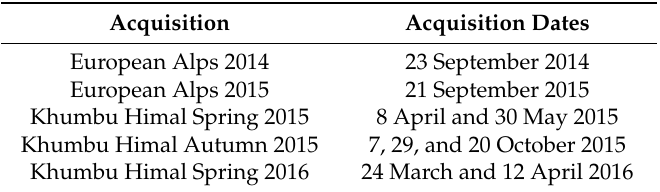
Table 1. Available Pléiades datasets.